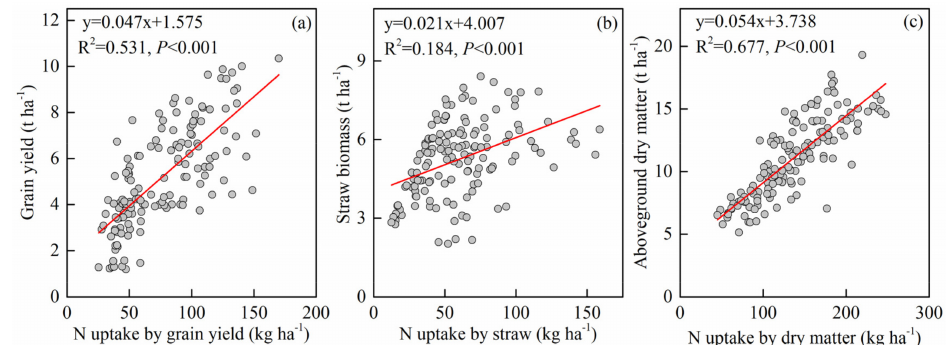
Figure 5. The relationship of N uptake with grain yield, straw biomass, and aboveground dry matter. ( a ) Relationship of N uptake by grain and grain yield. ( b ) N uptake by straw (stem and leaf) and straw biomass. ( c ) Relationship of N uptake by dry matter and aboveground dry